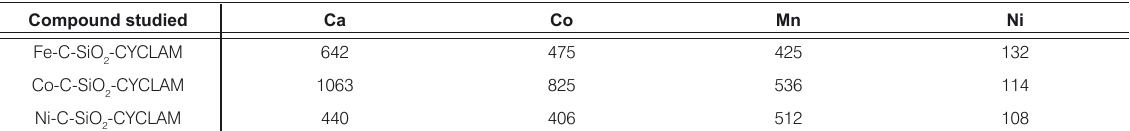
/ Cu M α ) in water solution, pH 5.0.